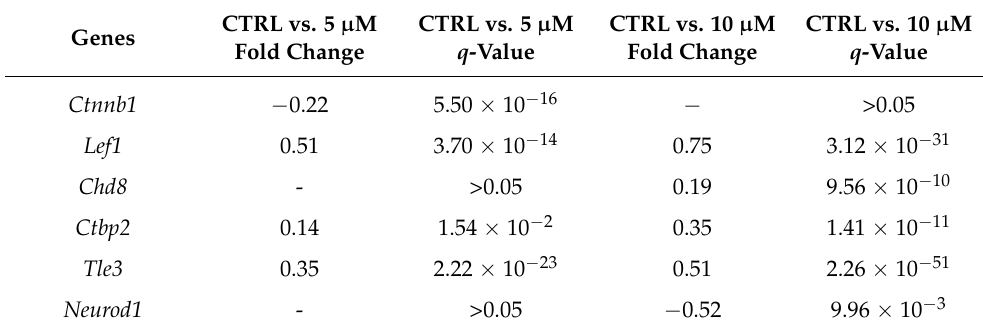
CTRL vs. 5 µ M Fold Change